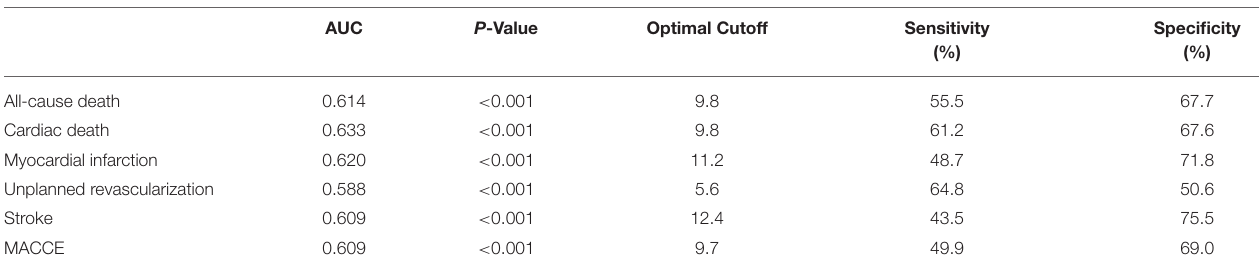
FIGURE 3 | Independent predictors of long-term clinical outcomes. (A) All-cause mortality. (B) Cardiac mortality. (C) Myocardial infarction. (D) Unplanned revascularization. (E) Stroke. (F) Major adverse cardiovascular and cerebrovascular events. CI, confidence interval; CRSS, clinical residual SYNTAX score; MACCE, major adverse cardiovascular and cerebrovascular events; MI, myocardial infarction; PCI, percutaneous coronary intervention. TABLE 4 | ROC curve analysis of CRSS regarding long-term clinical